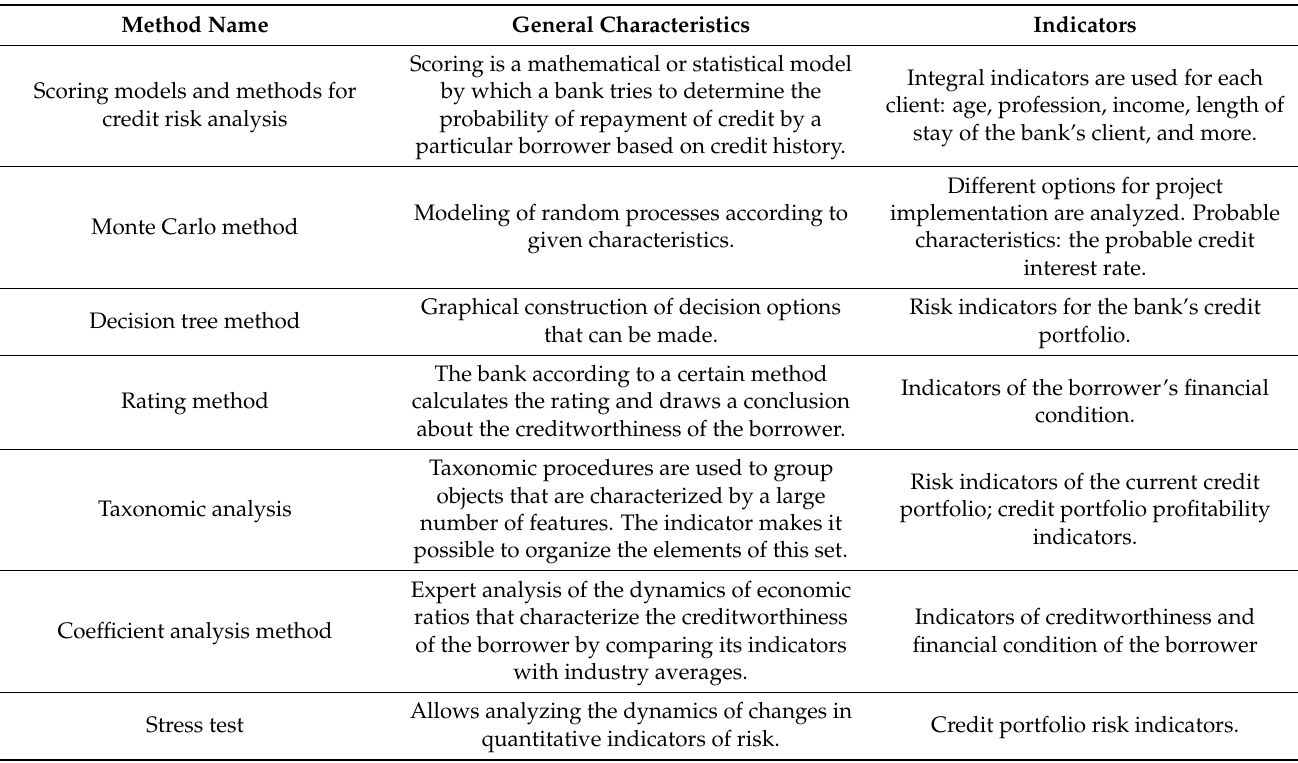
Table A1. Description of methods for assessing credit risks of banks.